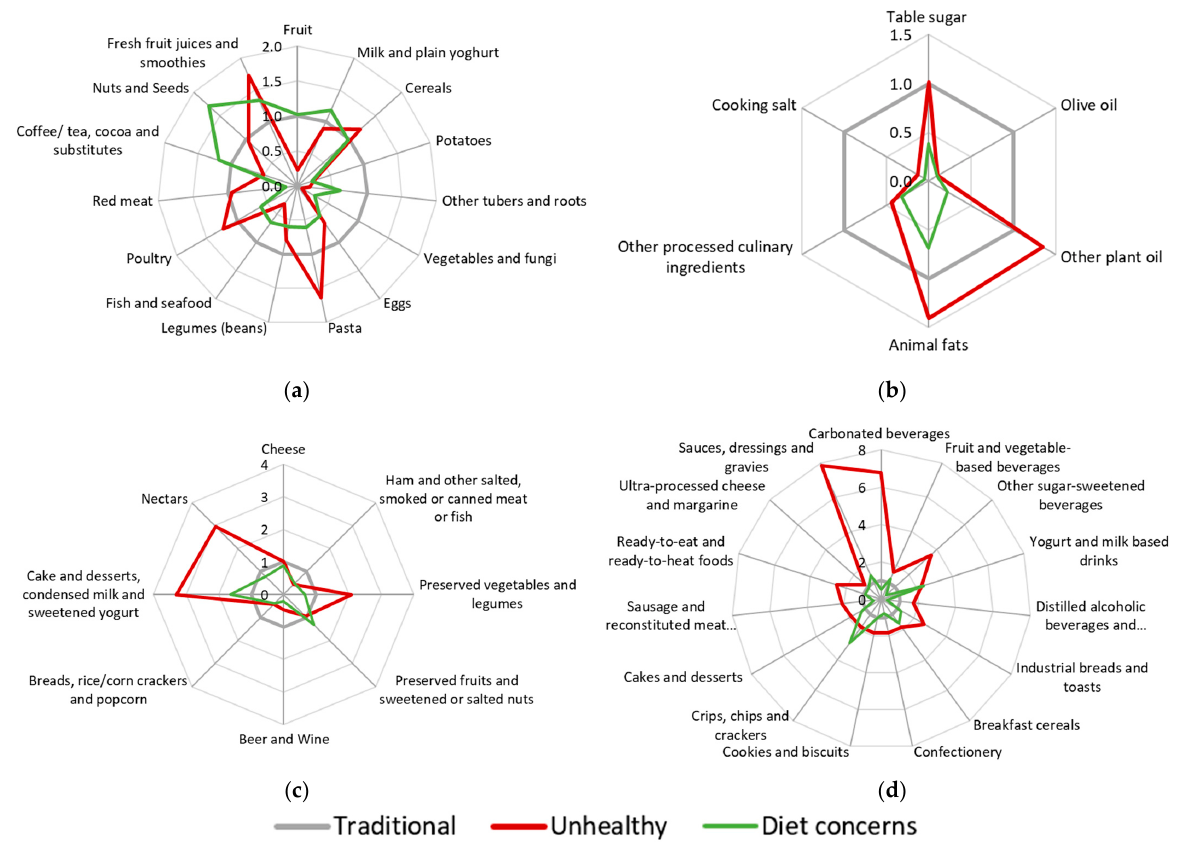
Figure 1. Odds ratio of being in the highest category of consumption of NOVA food subgroups for “Traditional”, “Unhealthy” and “Diet concerns” DPs: ( a ) Unprocessed or minimally processed food; ( b ) Processed culinary ingredients; ( c ) Processed food; ( d ) Ultra-processed food. Traditional DP was used as reference.